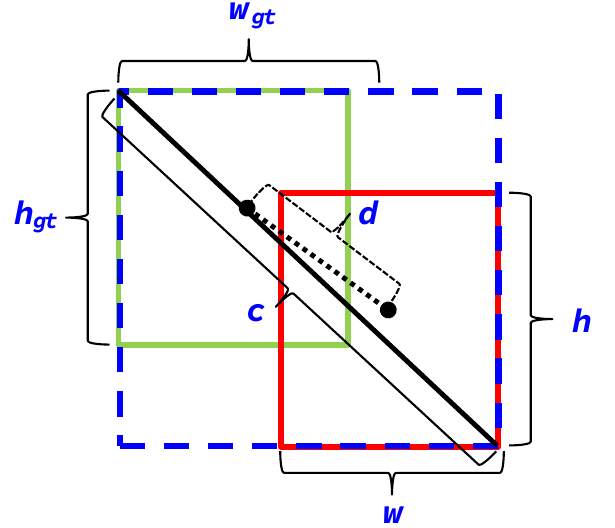
Figure 4. Schematic definition of precesion (P), recall (R) and intersection over union ( IoU ) during object detection.